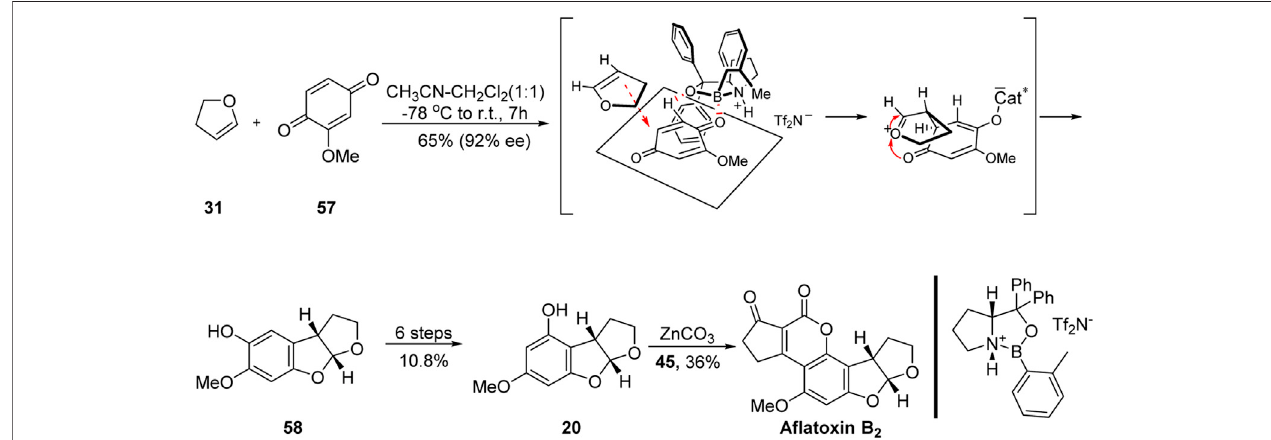
FIGURE 7 | First asymmetric total synthesis of a fl atoxin B